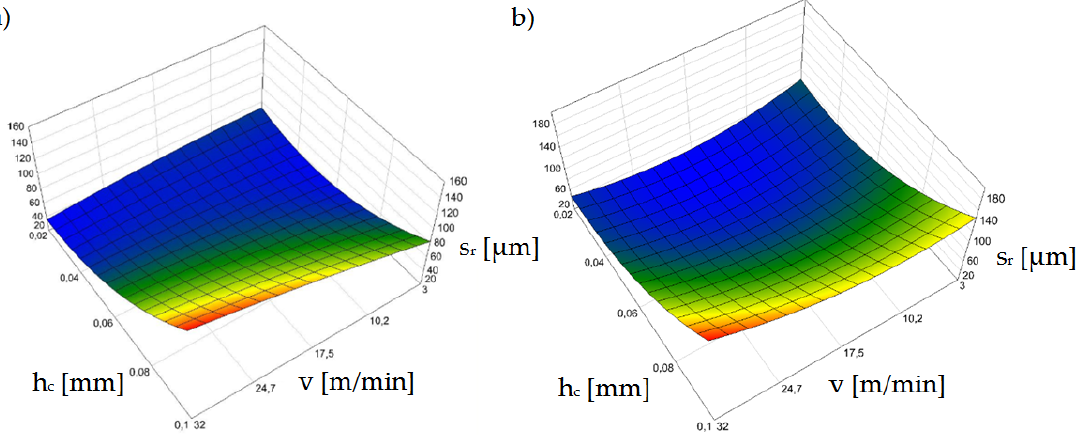
Figure 13. Graph of the dependence of the roll-over width ( s r ) on the cutting speed ( v ) and the horizontal clearance ( h c ): ( a ) uncoated material, ( b ) coated material . horizontal clearance ( h c ): ( a ) uncoated material, ( b ) coated